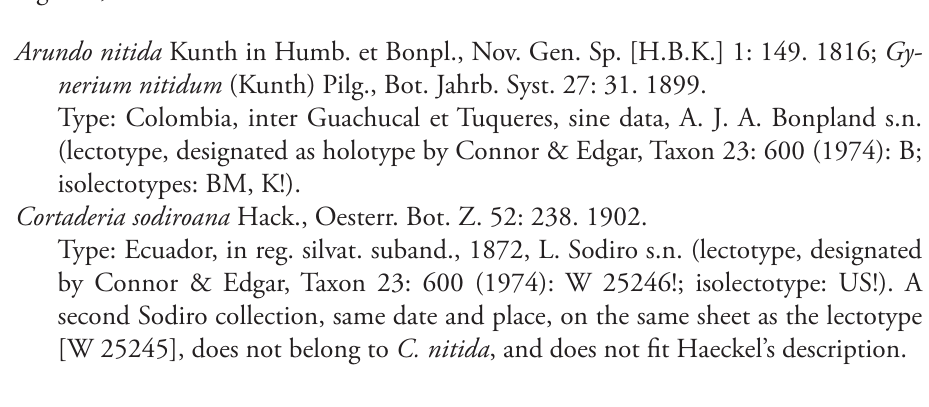
8. Cortaderia nitida (Kunth) Pilg., Bot. Jahrb. Syst. 37: 374. 1906. Figs 1H,